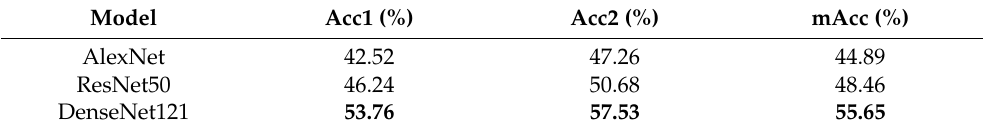
Table 4. Performance of three CNNs on the test set. The best metrics are highlighted in bold font.